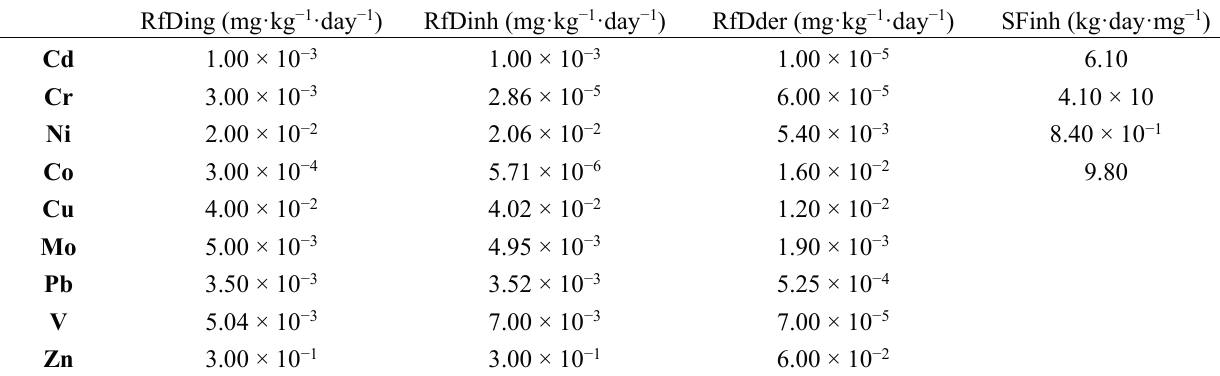
Table 2. The reference RfD and SF of heavy